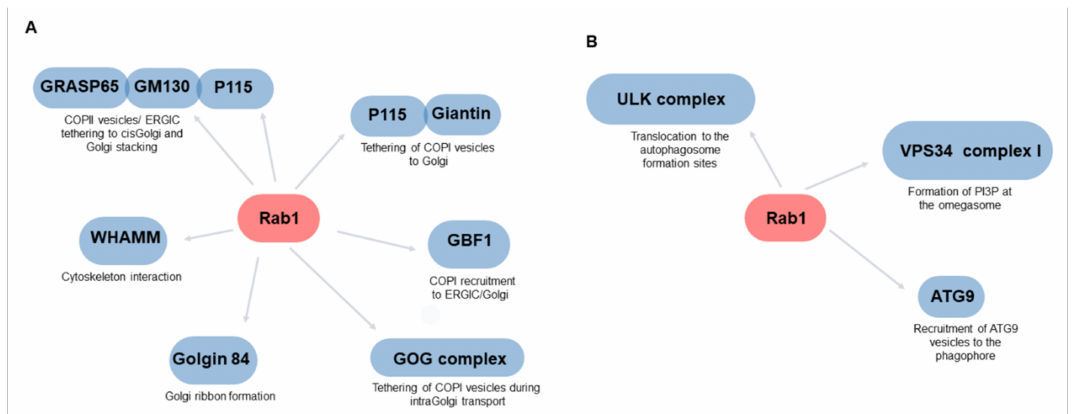
Figure 2. Main effectors of Rab1 involved in secretory traffic ( A ) and autophagy ( B ). Ypt1 is also involved in COPI-dependent retrograde transport from the Golgi [112]. Ypt1 interacts with COPI [113]. In contrast with Rab1A, Rab1B regulates COPI coat re- Golgi-specific brefeldin A-resistance guanine nucleotide exchange factor 1 (GBF1), which is the GEF that is specific for Arf1 [102], a GTPase involved in the recruitment of COPI components to membranes. In addition, Ypt1/Rab1 interacts with different subunits of